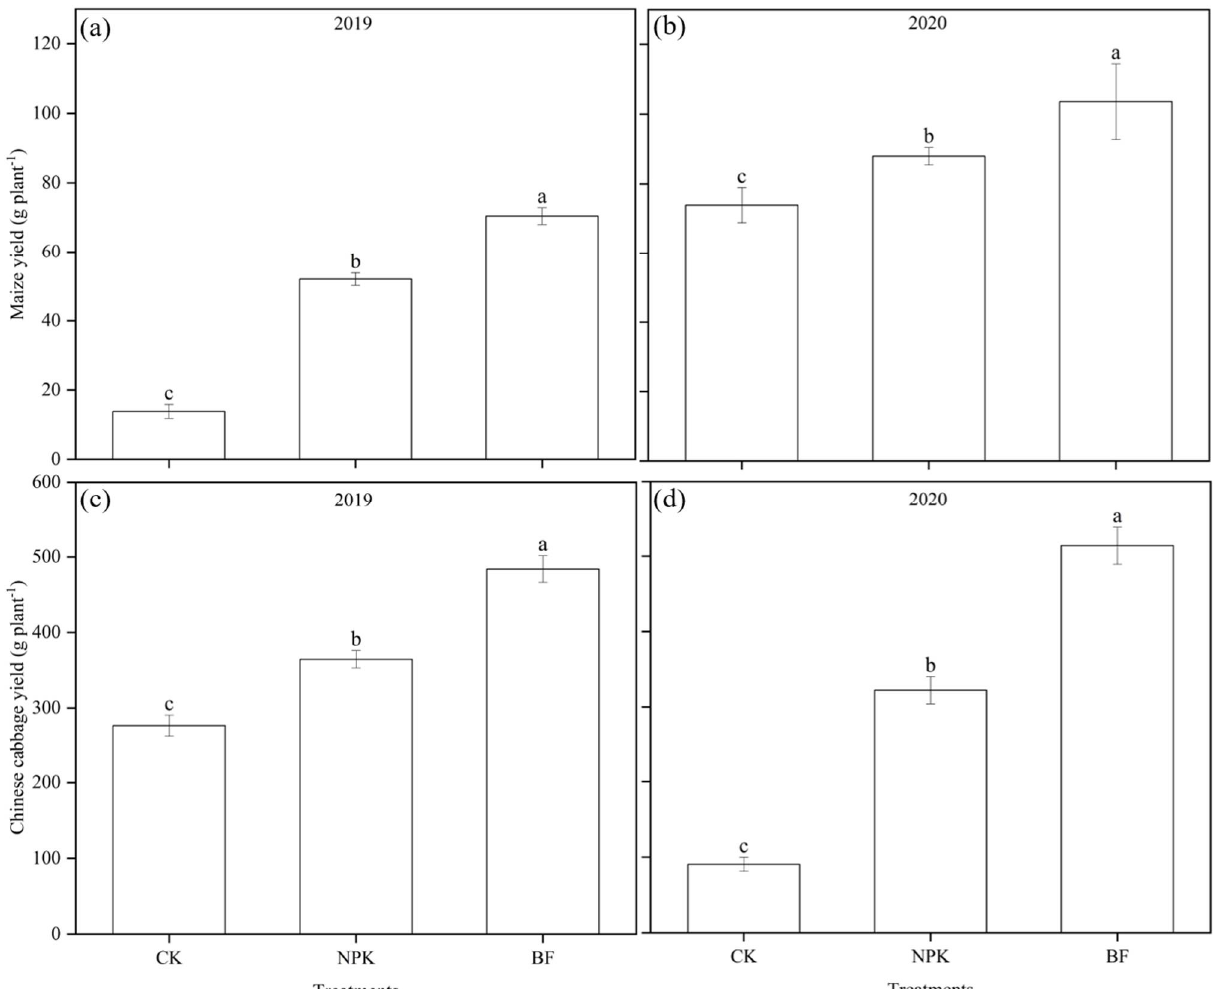
Figure 1. Yields of maize and cabbage in 2019–2020 under different N treatments. ( a ), Maize yield in 2019. ( b ), Maize yield in 2020. ( c ), Chinese cabbage yield in 2019. ( d ), Chinese cabbage yield in 2020. The error bars show the standard deviations of the means ( n = 3). Different lowercase letters indicate significant differences among treatments ( p < 0.05).